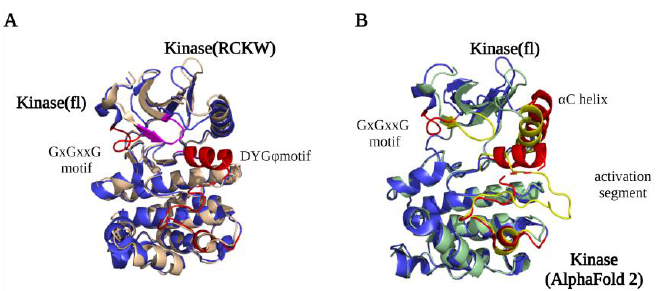
Figure 2. LRRK2 kinase domain structures. ( A ) An overlay of the kinase domain from LRRK2 RCKW (PDB ID: 6VP7) (light yellow) and flLRRK2 (PDB ID: 7LHW) (blue). The main difference between the structures is the conformation of the GxGxxG motif (highlighted LRRK2 RCKW in purple and flLRRK2 in red). ( B ) An overlay of the kinase domain from flLRRK2 (PDB ID: 7LHW) (blue) and AlphaFold2 model (green) structures. The GxGxxG motif, α C helix, and activation segments are highlighted in red (flLRRK2) and yellow (AlphaFold2),